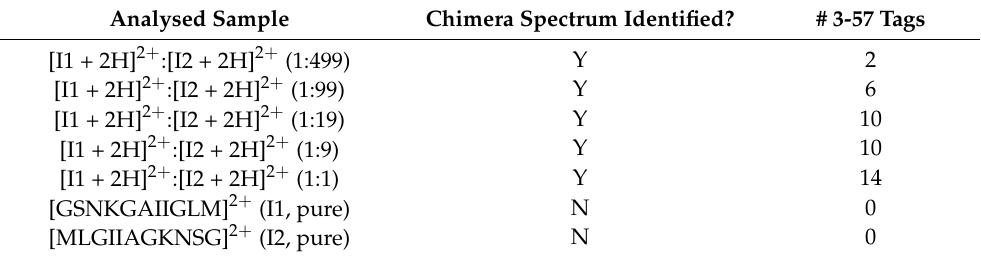
Table 1. 2D-PC-MS chimera spectrum identification using the 3-57 tags of the doubly charged ions of the mixtures of the isomeric sequences GSNKGAIIGLM ( I1 ) and MLGIIAGKNSG ( I2 ) across different relative molar concentrations (ratios given in brackets). The number of the 3-57 tags (such as those shown in Figure 2) is seen to increase with increasing I1 concentration. As expected, no chimera tags are detected in the pure peptide 2D-PC-MS